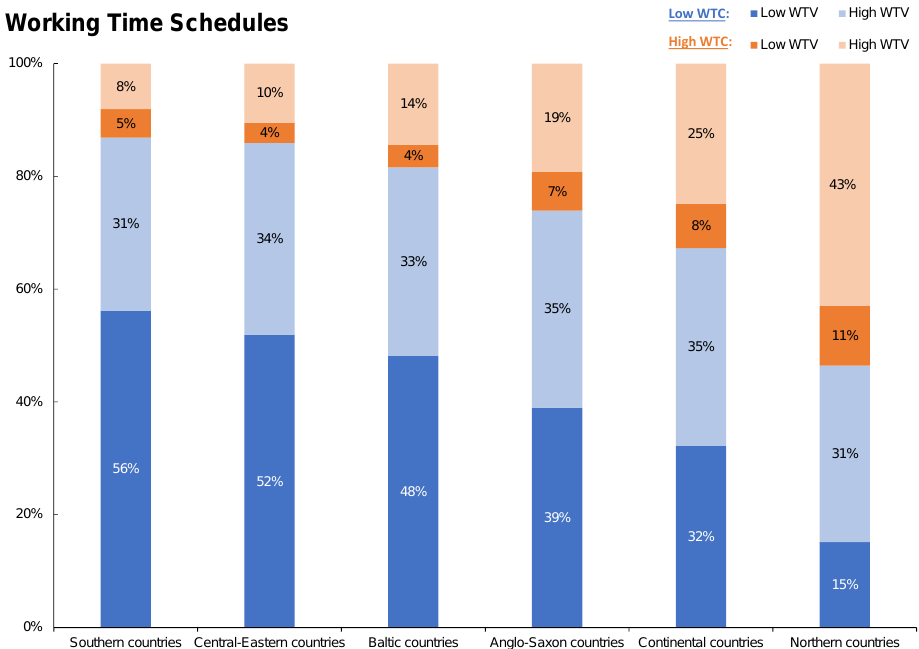
Figure 2. Distribution of working time schedules (WTC and WTV) across European country clus- ters, weighted by country weights, Anglo-Saxon countries: Ireland, UK; Baltic countries: Estonia, Latvia, Lithuania; central-eastern countries: Bulgaria, Croatia, Czech Republic, Hungary, Poland, Romania, Slovenia, Slovakia; continental countries: Austria, Belgium, France, Germany, Luxembourg, Netherlands; northern countries: Denmark, Finland, Sweden; southern countries: Cyprus, Greece, Italy, Malta, Portugal, Spain; WTC: working time control; WTV: working time variability. Occupational sectors . WTV and WTC slightly differ between occupational sectors (see Figure 3). Compared to the overall sample (25%), workers in all three sectors have high WTC Table 2. Multi-level